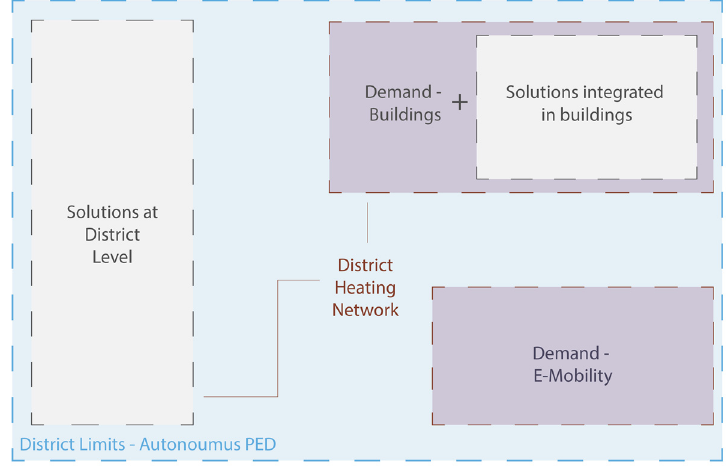
Figure 1. Autonomous PED.